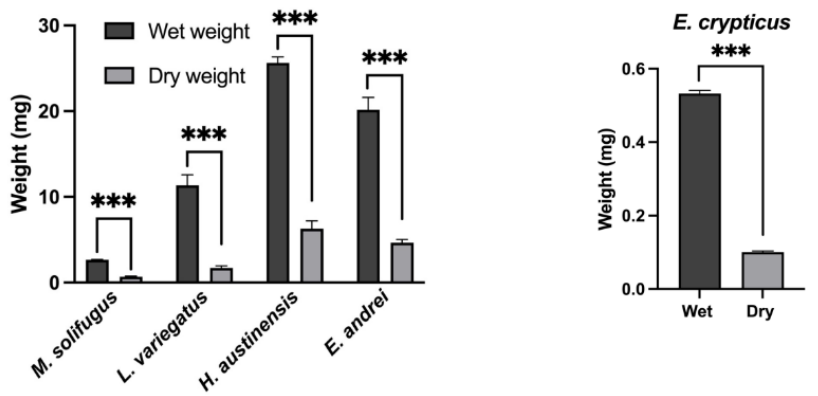
Figure 1. Annelida included in this study have different wet and dry weight values. Wet and dry weight values were calculated for all the animals used on this study. The levels of polyP were normalized considering these values. Data are expressed as mean ± SEM of, at least, three independent experiments conducted using biological triplicates. Values of p ≤ 0.05 were considered significant (*** p ≤ 0.001).